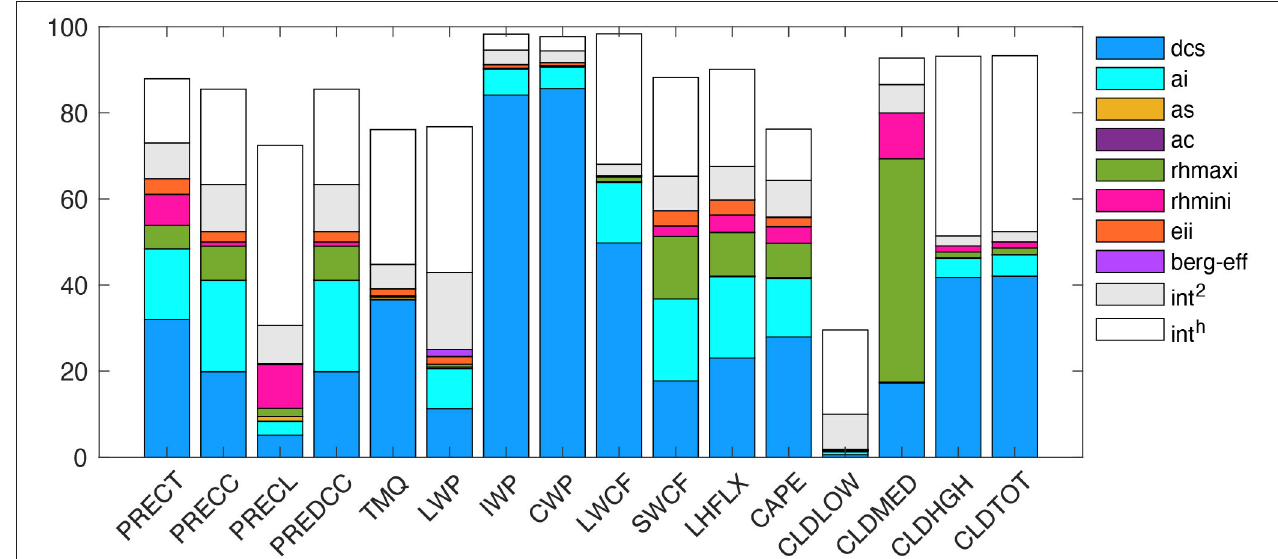
FIGURE 4 | Relative contributions of variance for individual parameters (main effect) to the overall variance of different climatic variables. The total contribution of variance from the second-order (two-way) interaction between parameters is indicated by the gray box in the bar plot (Int 2 ); the remainder of the contribution to variance from the higher-order (i.e., order > 2) interactions among other parameters is indicated by a white box for each